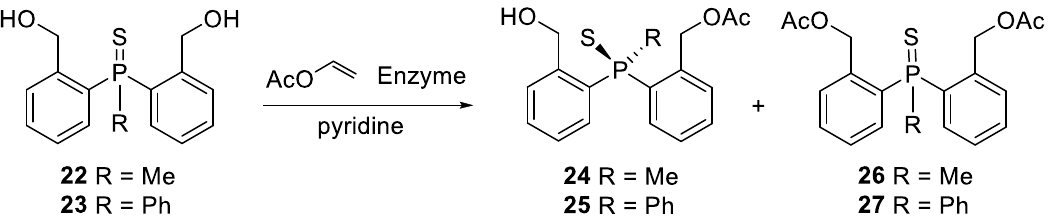
Scheme 6. Desymmetrisation of bis (2-hydroxymethylphenyl)phosphine sulfides 22 and 23